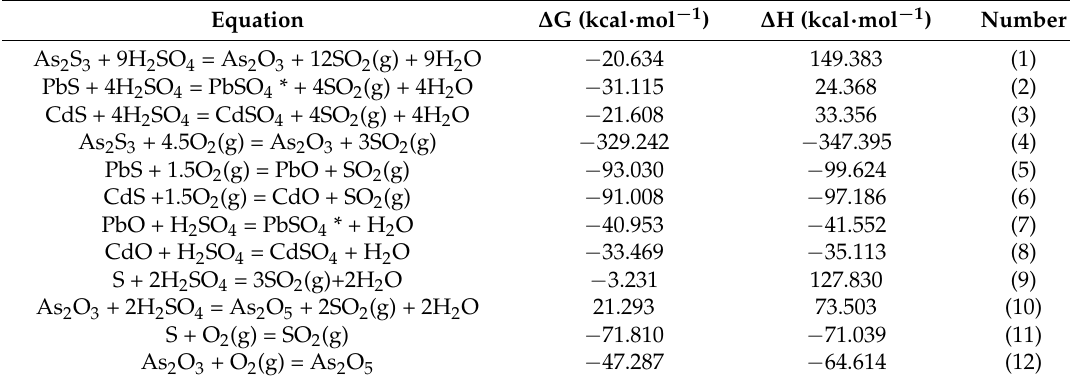
The thermodynamic data were calculated by the HSC Chemistry Software Version 6.0 (Outokumpu Research Oy, Finland) at 60 °C. * Slightly soluble in water.